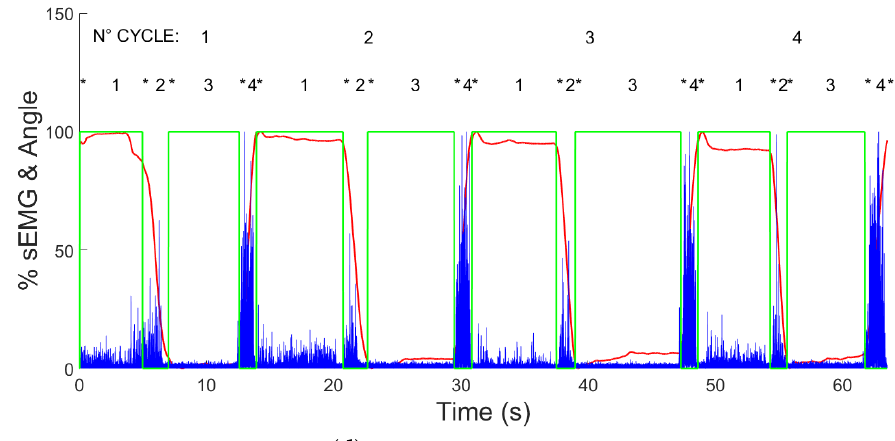
Figure 7. Myoelectric activity for each phase and each muscle. Blue signal represents the sEMG normalized respect the max value of the cycle and it is expressed in percentage terms. The red signal is the inclination signal normalized respect the max value in the cycle and it is expressed in percentage terms. The green graph is the phases signal. They are referred to the same healthy subject of the previous